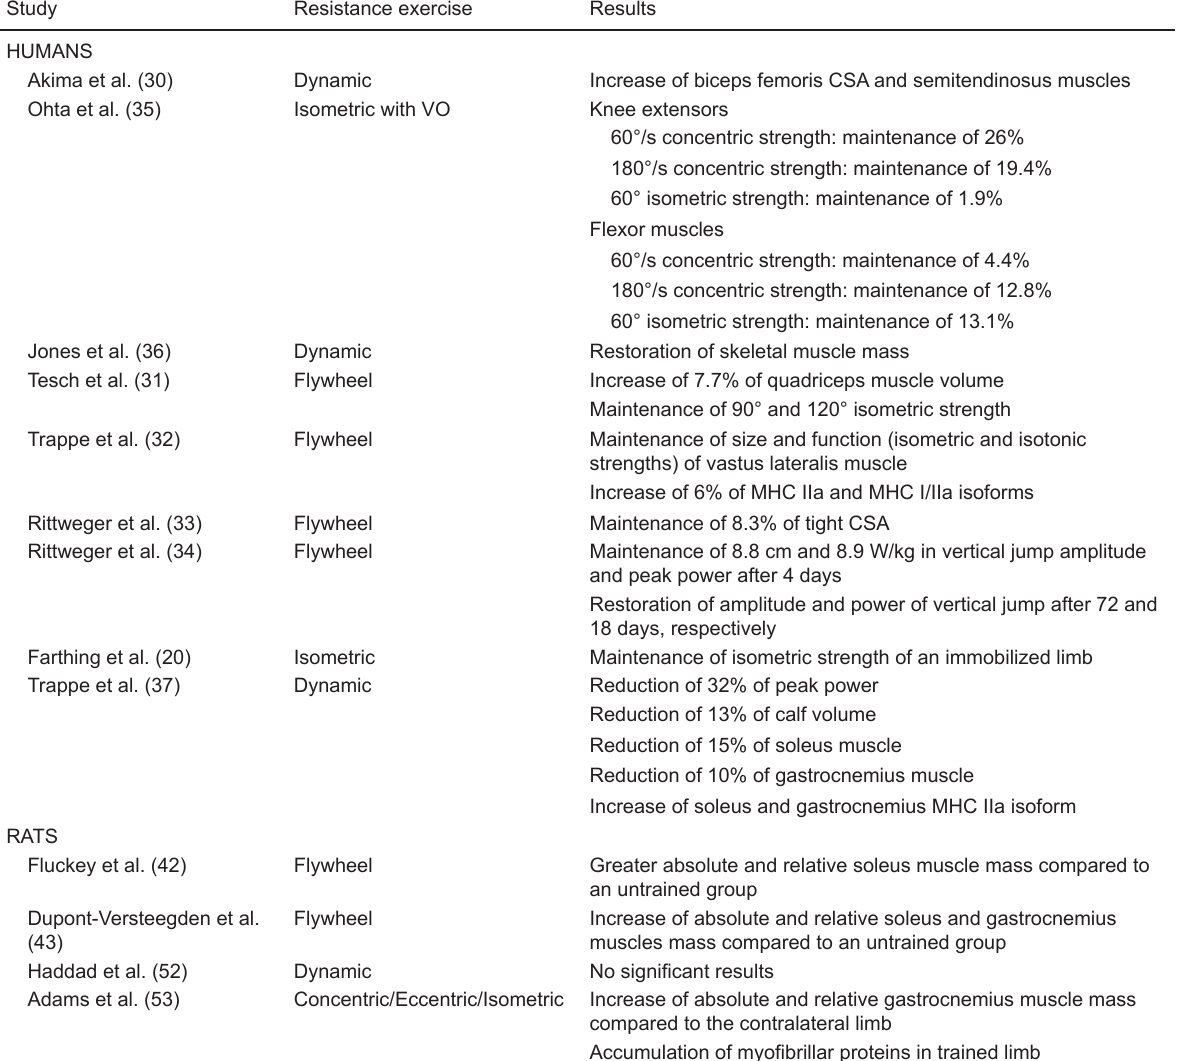
Table 1. Effects of different forms of resistance exercise on functional and morphological responses of disuse-induced atrophied skel- etal